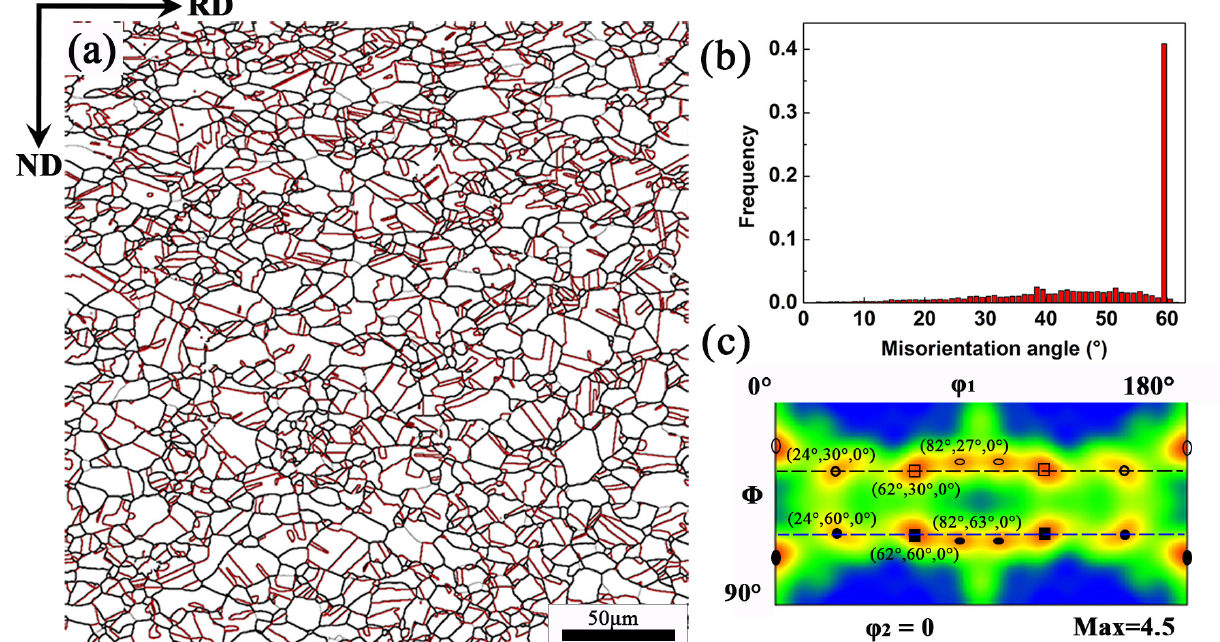
Figure 6: (a) Grain boundary map showing microstructure, (b) misorientation distribution map and (c) φ 2 = 0 ∘ section ODF of the sample annealed at low temperature of 550 ∘ C for 1 h.